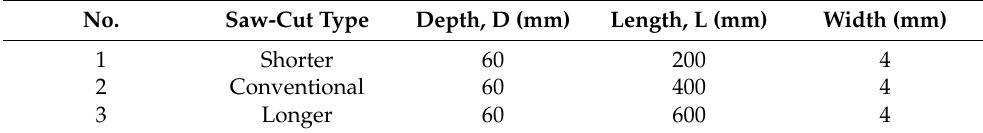
Figure 15. Comparison of maximum steel stress over along the length of the longitudinal steel bar for different saw-cut lengths.